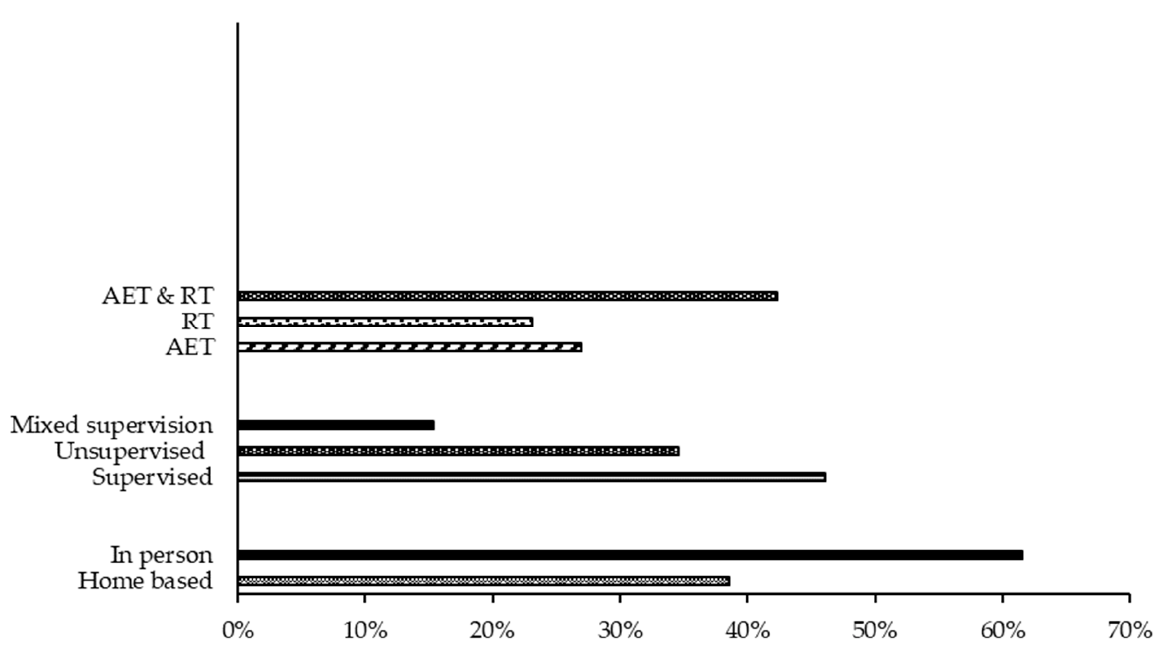
Figure 2. Characteristics of the exercise interventions used in reviewed studied (%). Abbreviations: AET, aerobic training; RT, resistance training.